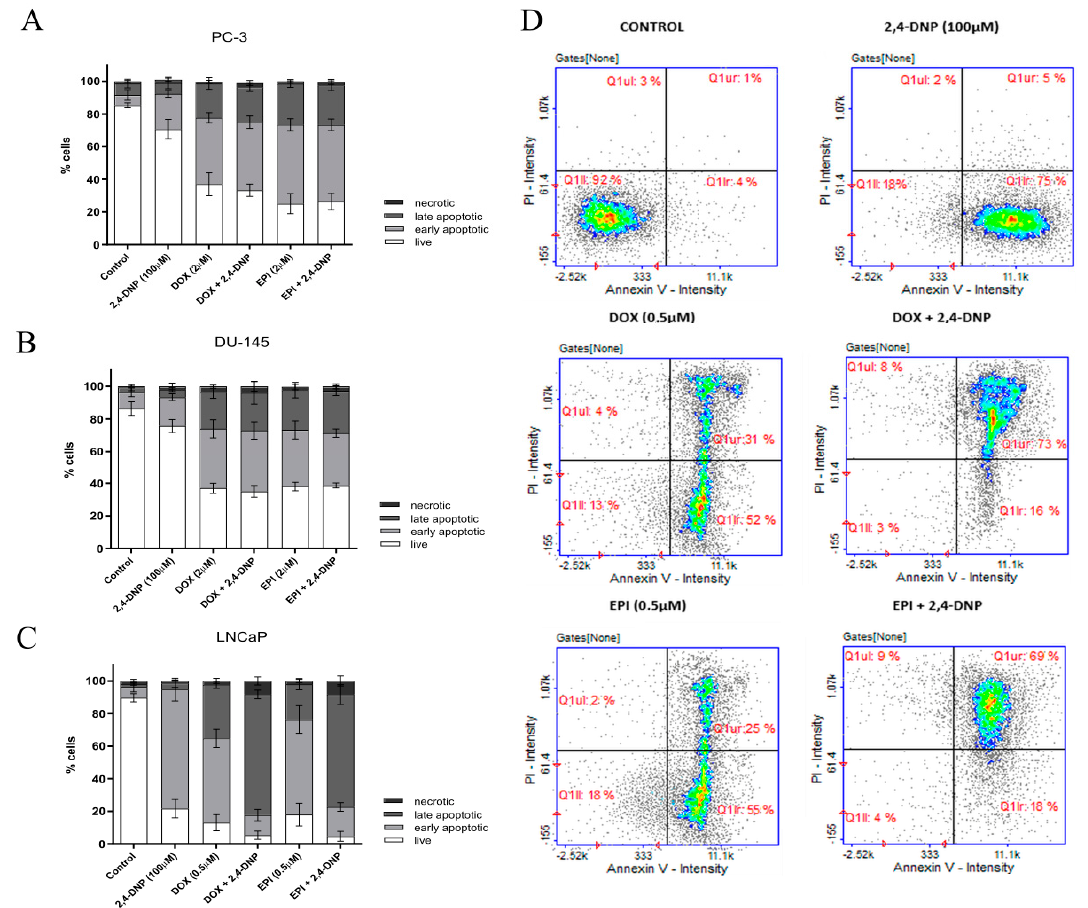
Figure 6. Detection of apoptosis analysis of ( A ) PC-3, ( B ) DU-145, ( C ) LNCaP cell lines. The cells were treated for 48 h with 2,4-DNP, DOX, and EPI or combined (2,4-DNP + EPI, 2,4-DNP +